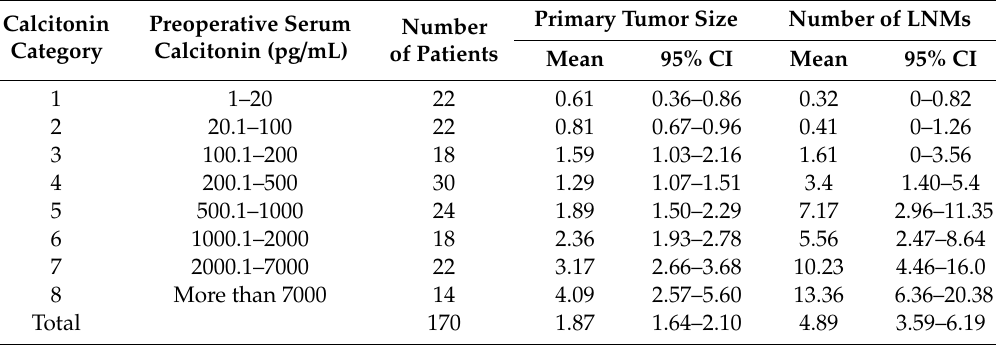
Table 3. Tumor extent and cancer prognosis according to preoperative serum calcitonin levels.